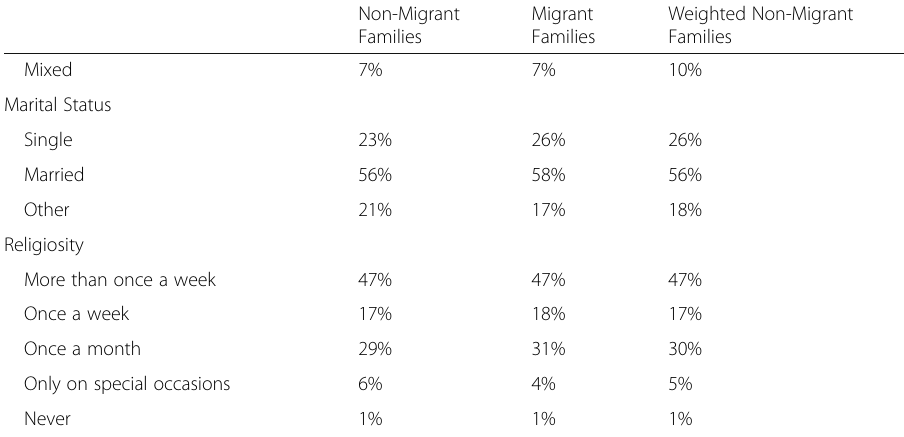
Table 1 Distribution of Selected Characteristics by Migration Treatment and Control Groups